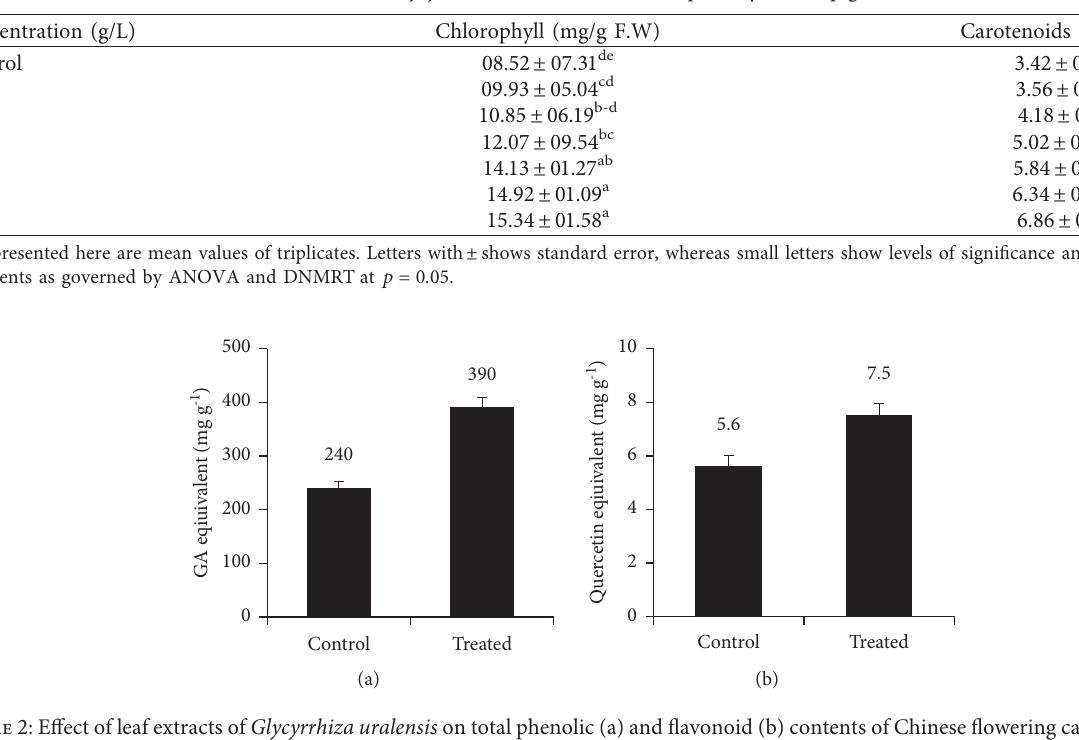
Table 2: Effect of Glycyrrhiza leaf extracts on leaf photosynthetic pigments.